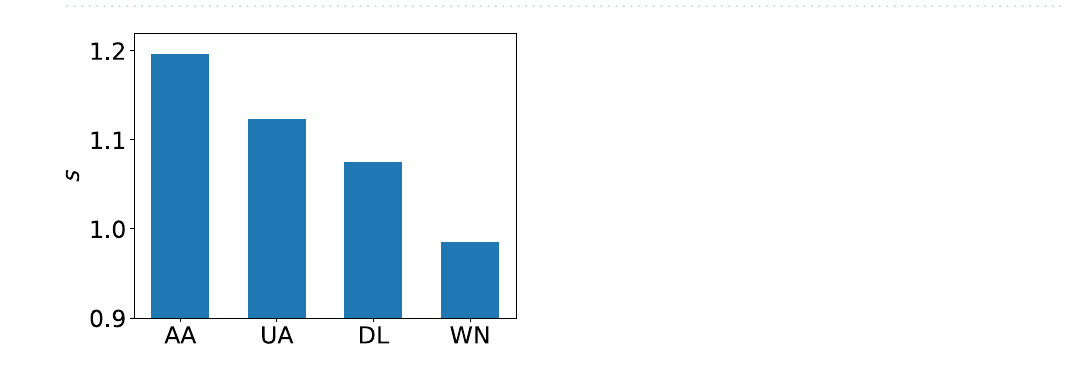
Figure 4. Analysis of autocorrelation and periodicity. ( a ) ACFs and ( b ) PSDs for the four carriers.